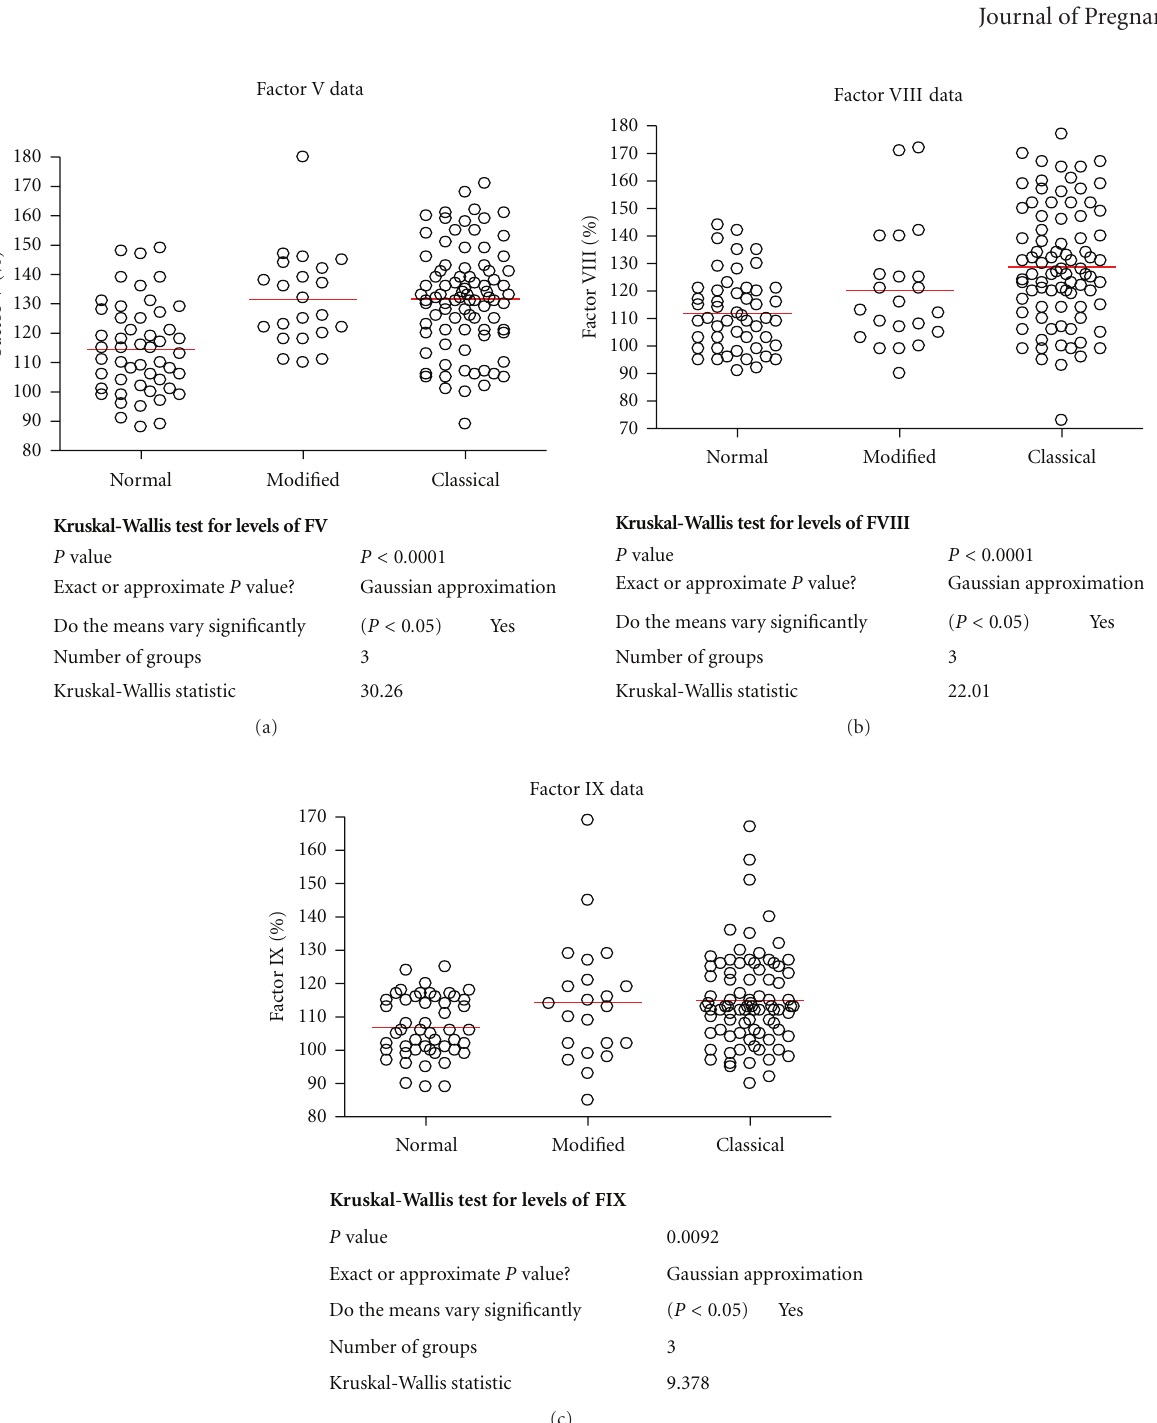
15% reported in Northern Sweden [33]. APCR in the general population and during pregnancy is reported to be most frequently caused by FVL mutation [34–36], inherited